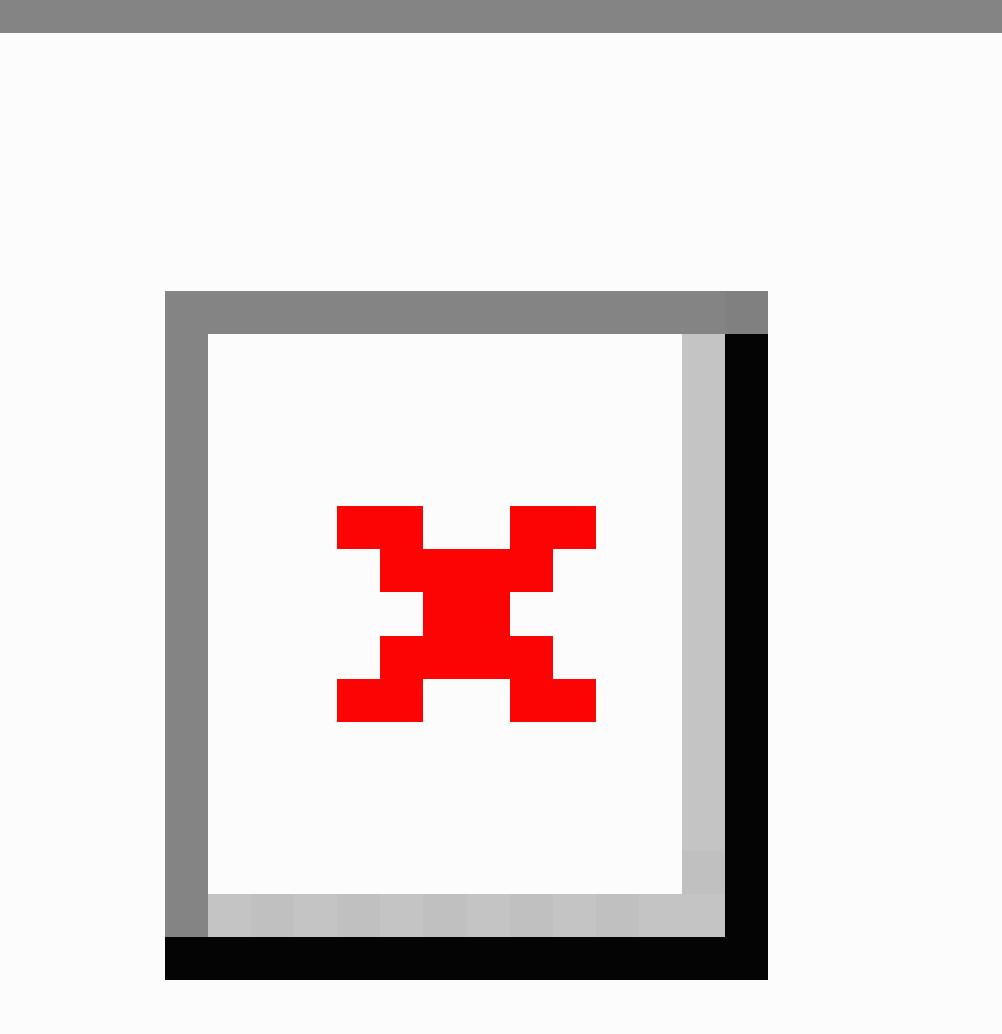
Figure 4. (a) Experts were concerned with the small button size and the fact that the password was encrypted meaning an older adult might lose their place when typing. This problem was also identified by end users; (b) Increased text size and a larger, more prominent sign in button as well as a decrypted